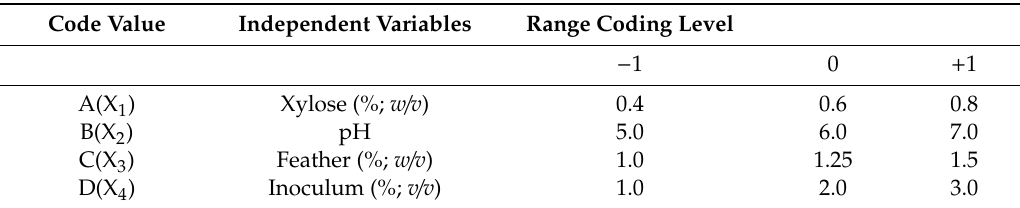
Table 1. Experimental ranges of four parameters used in the central composite design of response surface methodology